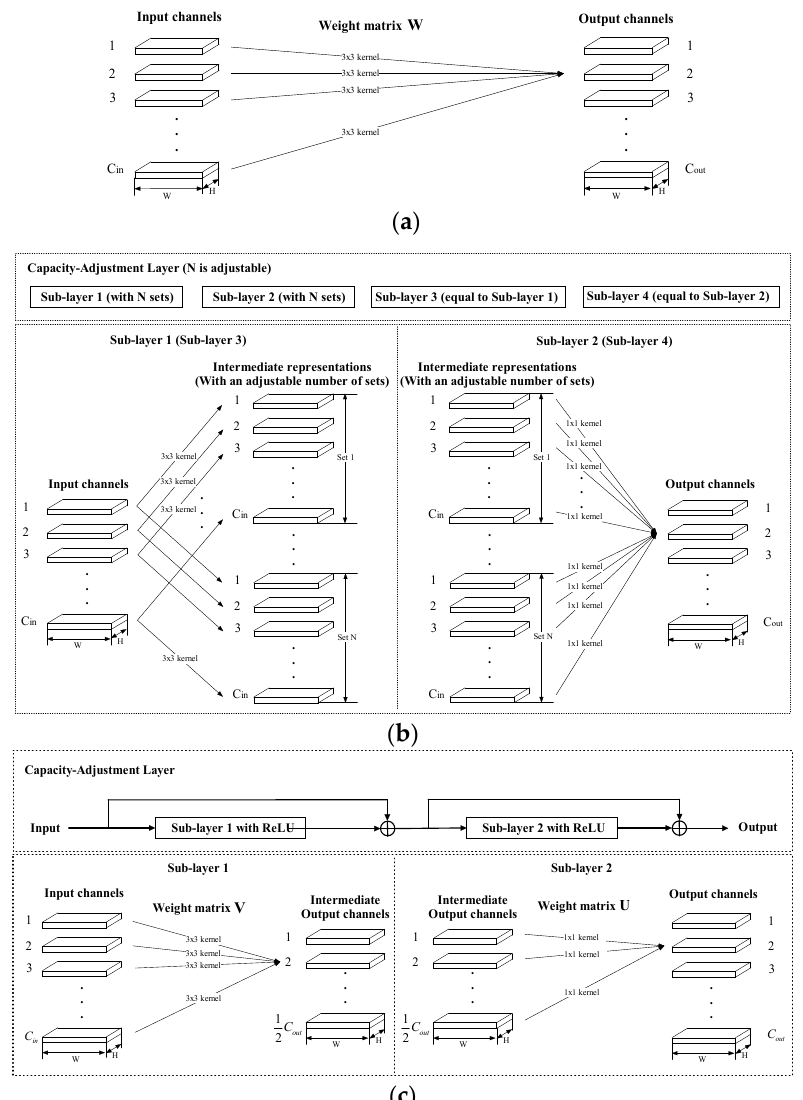
Figure 5. The proposed way of exchanging width for depth: ( a ) A conventional convolutional layer; ( b ) simplify one conventional layer to sub-layers and concatenate M ( M = 4 ) sub-layers to replace one conventional layer. Each sub-layer is obtained by decomposing one conventional layer and increasing the dependency between convolutional kernels; ( c ) simplify one conventional layer to sub-layers and stack 2 sub-layers to replace one conventional layer.